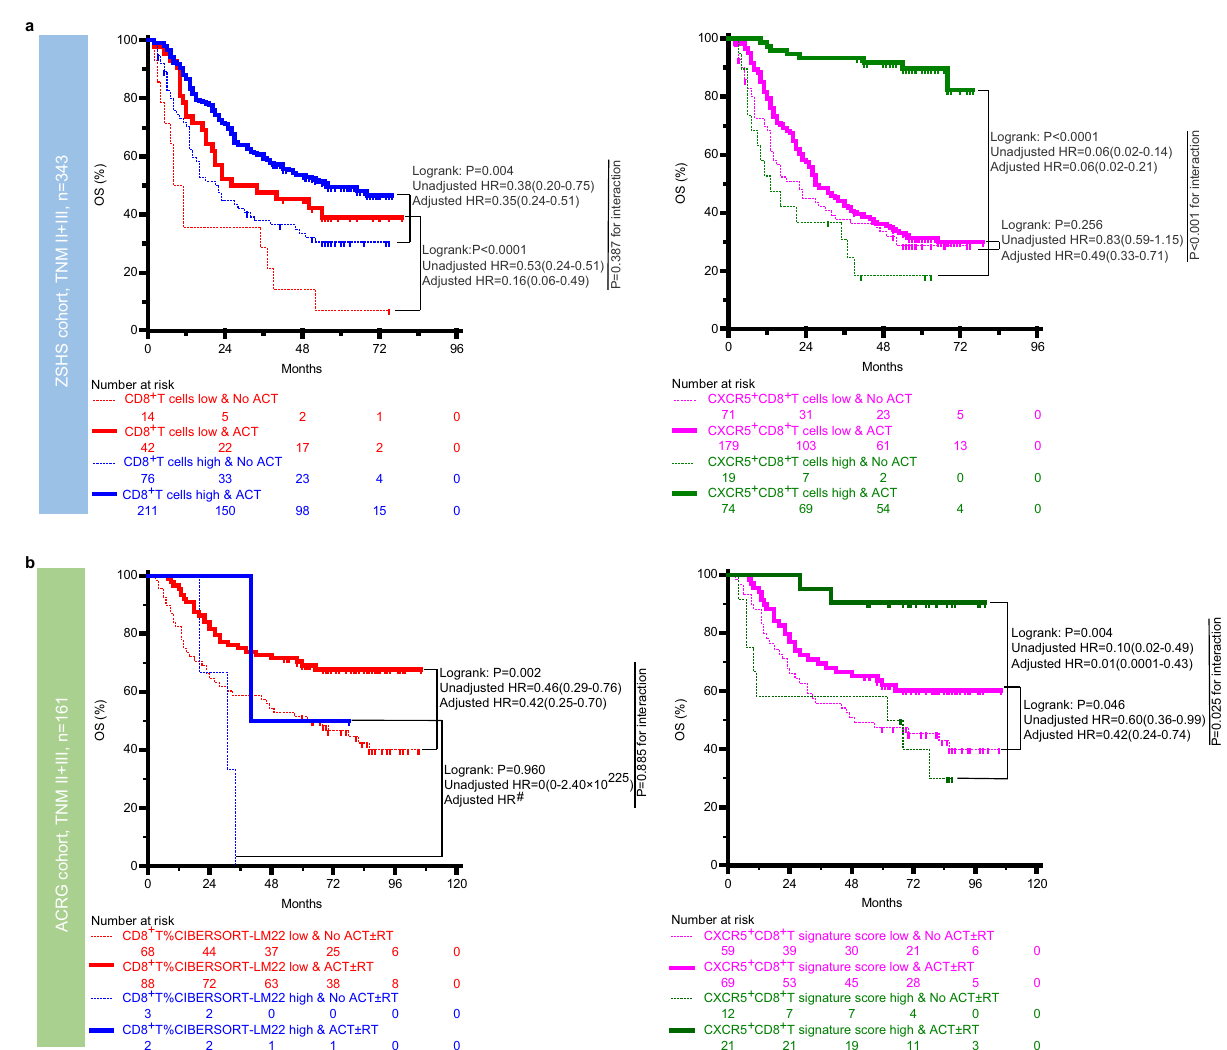
Fig. 3 CXCR5 + CD8 + T is associated with superior response to ACT. a , b Survival curves for the use of ACT (±RT) in patients with high/low CD8 + T/ CXCR5 + CD8 + T cell in fi ltration in the a ZSHS and b ACRG cohorts. HRs of disease mortality for patients with ACT (±RT) versus without according to tumor CD8 + T/CXCR5 + CD8 + T cell in fi ltration and interaction between the biomarker and treatment were reported. The response to ACT (±RT) analysis was conducted in patients with TNM II + III stage diseases. P value shown resulted from the comparison between with and without ACT (±RT) treatment of n = 343 (ZSHS TNM II + III cohort) and n = 161 (ACRG TNM II + III cohort) patients with gastric cancer, using the Kaplan – Meier method followed by log-rank statistical test; the unadjusted and adjusted HRs and 95% CIs are reported. # Sample size too small to conduct multivariate Cox analysis. Source data are provided as a Source data fi le. ZSHS Zhongshan Hospital, ACRG Asian Cancer Research Group, HR hazard ratio, CI con fi dence interval, ACT adjuvant chemotherapy, RT